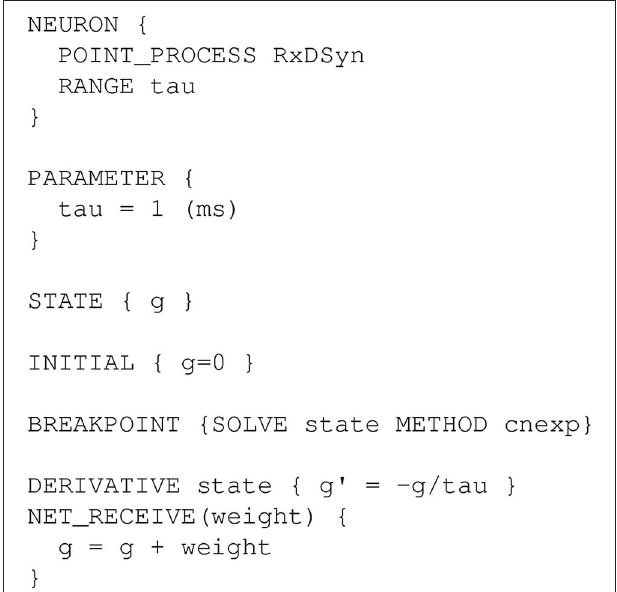
FIGURE 13 | Source code for a generic NMODL mechanism called RxDSyn that receives synaptic events ( NET_RECEIVE block) causing the flux g to increase abruptly in response to an event by an associated weight, with the flux decaying exponentially with time constant tau thereafter ( DERIVATIVE